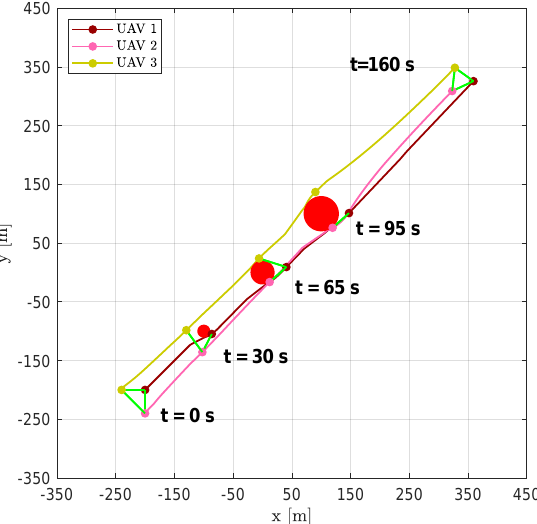
Figure 6. Scenario #1—three aircraft: UAVs’ trajectories. Red circles represent the obstacles; colored markers indicate positions at different time instants; green straight lines highlight DTG arcs.